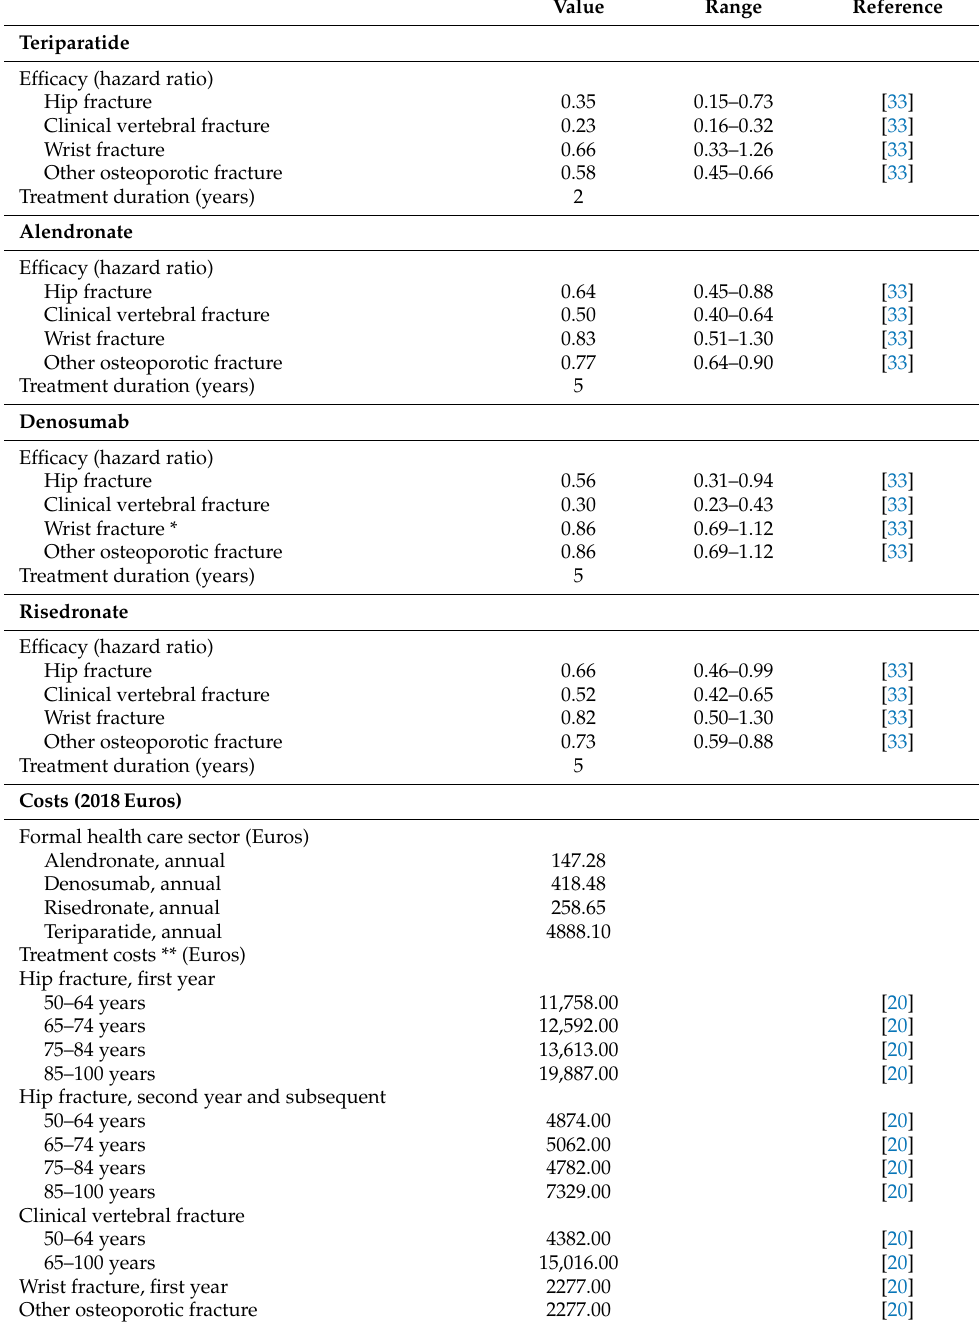
Table 3. Model parameters in this